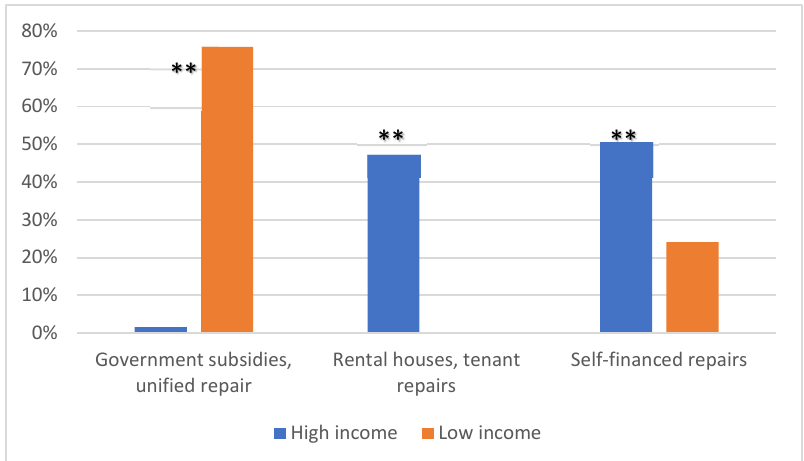
Figure 5. Variations in management mode as perceived and preferred by respondents concerning different income levels. Asterisks indicate significance level: ** means p ≤ 0.01.